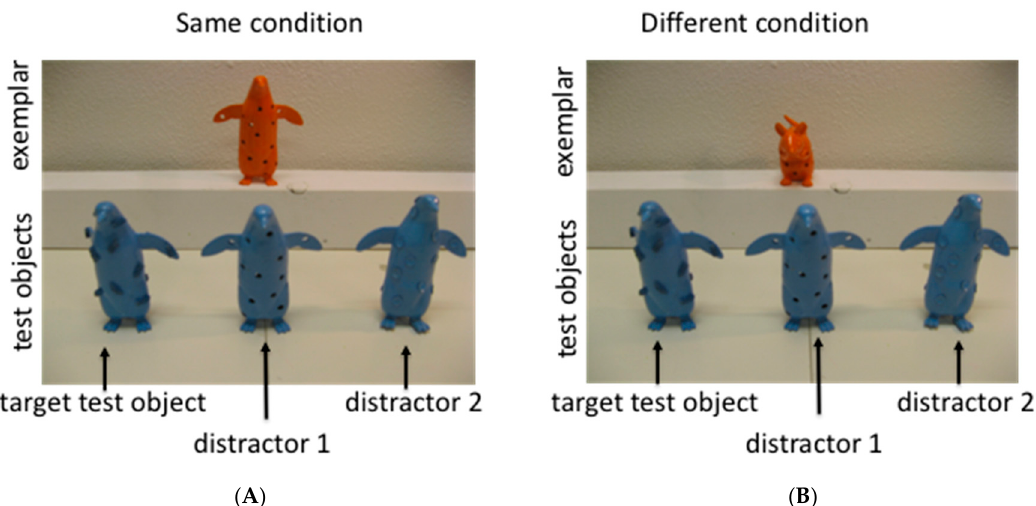
Figure 3. One of the six stimulus sets used in the Same category condition ( A , left ) and in the Different category condition ( B , right ).